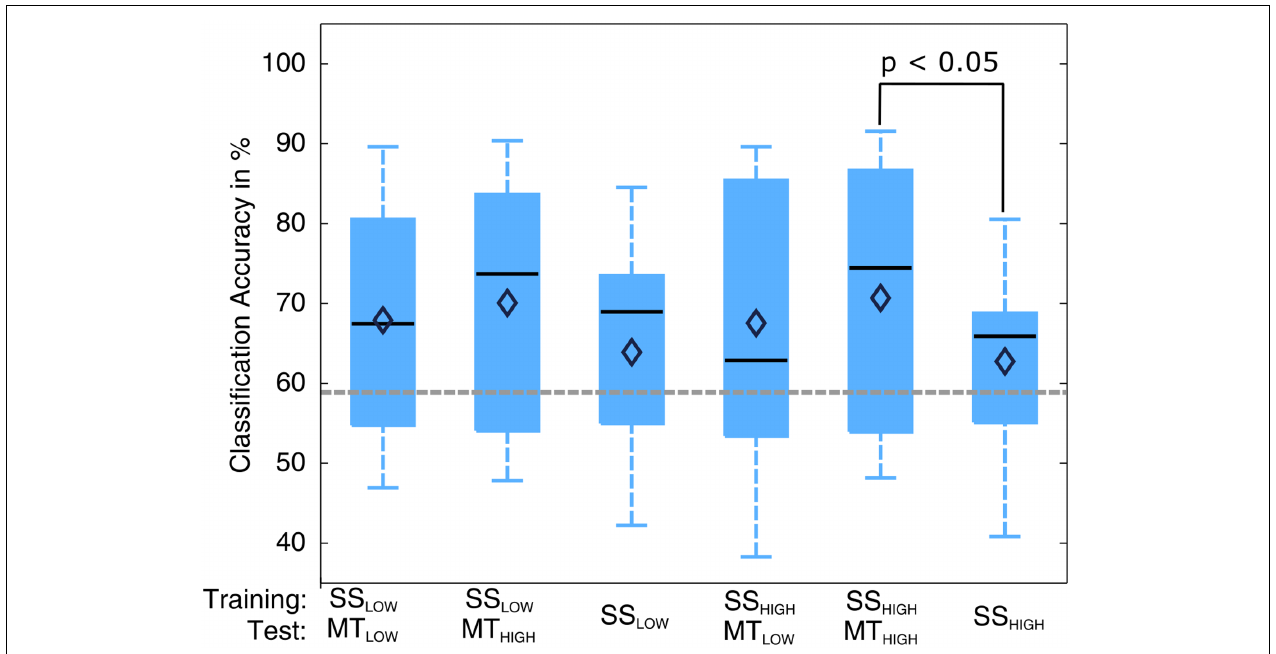
FIGURE 9 | Box plots depicting the results of the cross-classification (CC) using MT trials as input for classifiers trained on the classification of sensory stimulation (SS) trials. Upper row denotes the trials that were used in the training step; lower row denotes the trials that were used in the testing step, i.e., evaluation of the classification performance. All CCs performed significantly above chance ( p < 0.05). The CCs trained on SS and tested with MT trials reached higher classification accuracies than the regular SS classifiers (third and sixth). The CC trained on SS HIGH (high intensity of SS) and tested on MT HIGH (high force in the MT) even performed significantly better than the regular SS HIGH classifier. The classification accuracy of the CC trained on SS LOW (low intensity of sensory stimulation) and tested on MT HIGH was not significantly higher than the regular SS HIGH classifier but indicated a trend ( p < 0.09). The vertical dotted gray line depicts the statistical chance level (58.9%). Mean classification accuracies are depicted by the diamond. Central lines within the boxes represent the